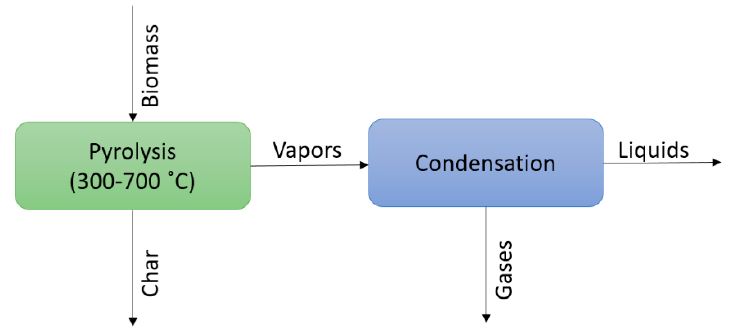
Figure 1. Schematic description of basic biomass pyrolysis system.